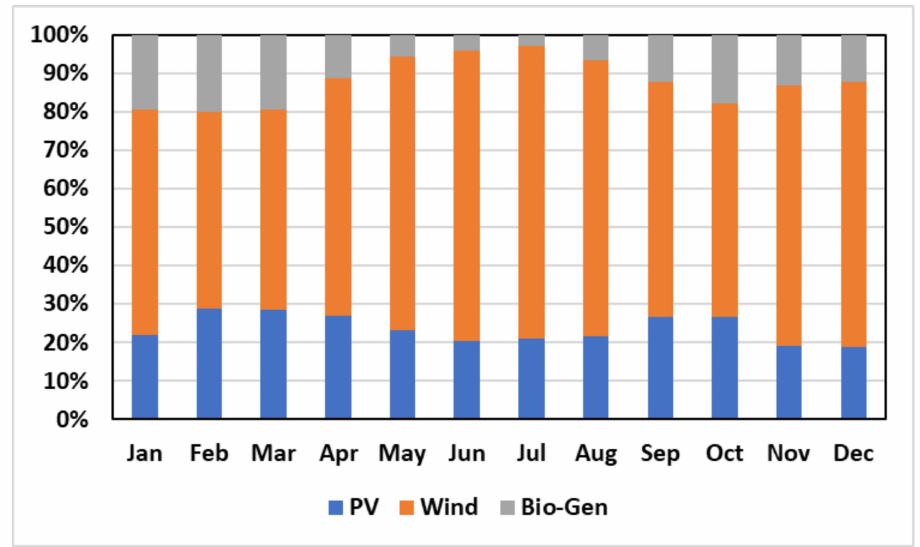
Figure 9. Monthly energy contribution of